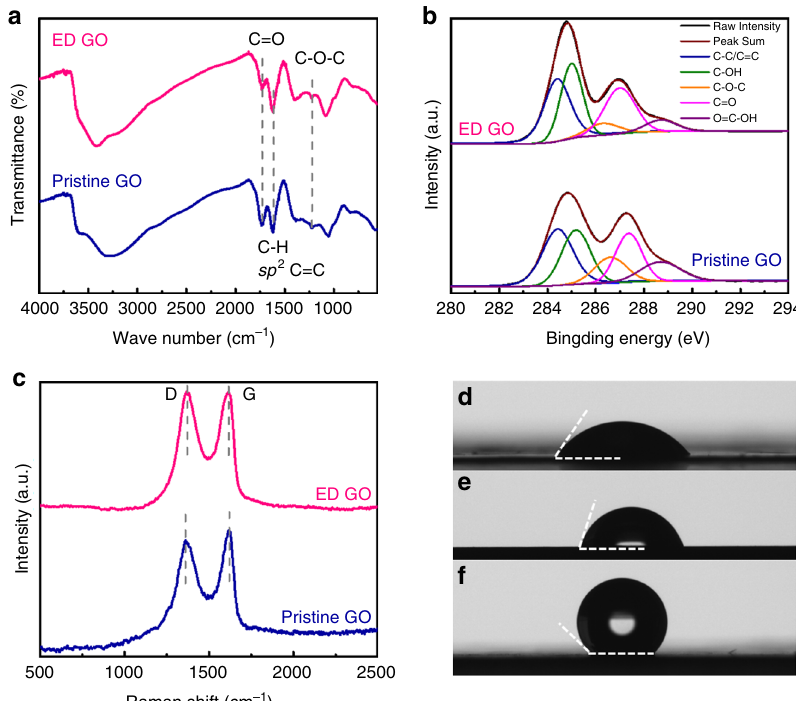
Fig. 4 Chemical and surface properties of pristine GO and ED-GO. The pristine GO and ED-GO samples measured by a FTIR spectroscopy, b XPS and c Raman spectroscopy; the static WCA of d GO membrane prepared by fi ltration, e ED-GO membrane and f graphene membrane prepared by fi